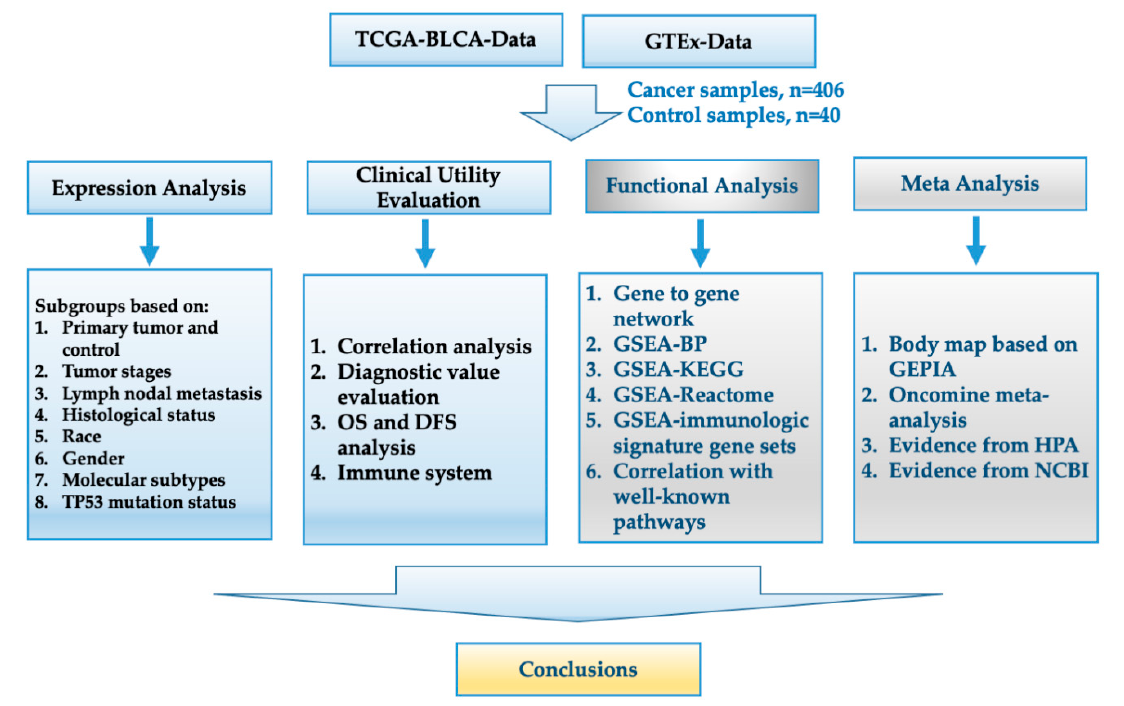
Figure 1. Study design. The workflow of the analysis steps. TCGA: The Cancer Genome Atlas; BLCA: bladder cancer; GTEx: the genotype-tissue expression; OS: overall survival; DFS: disease-free survival; GSEA: gene set enrichment analysis; BP: biological process; KEGG: Kyoto Encyclopedia of Genes and Genomes; GEPIA: gene expression profiling interactive analysis; HPA: human protein atlas; NCBI: National Center for Biotechnology Information.